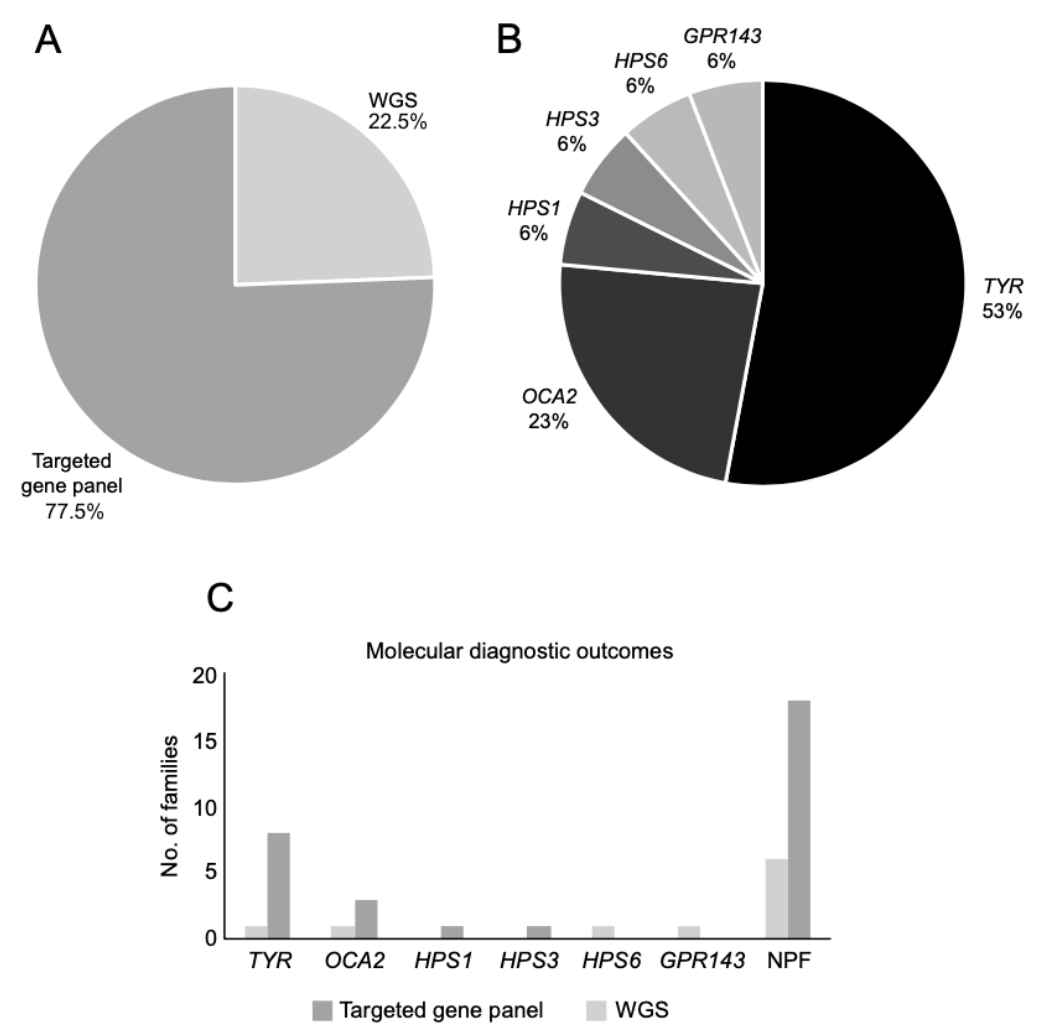
Figure 3. ( A ) Proportion of families who underwent whole genome sequencing (WGS) and targeted gene panel testing seen through the ocular genetics service between November 2017 and September 2019 at MEH (Moorfields Eye Hospital NHS Foundation Trust). ( B ) Mutational spectrum of families with positive molecular findings. ( C ) Molecular diagnostic outcomes for WGS and targeted panel sequencing for the entire cohort. NPF = no primary findings.